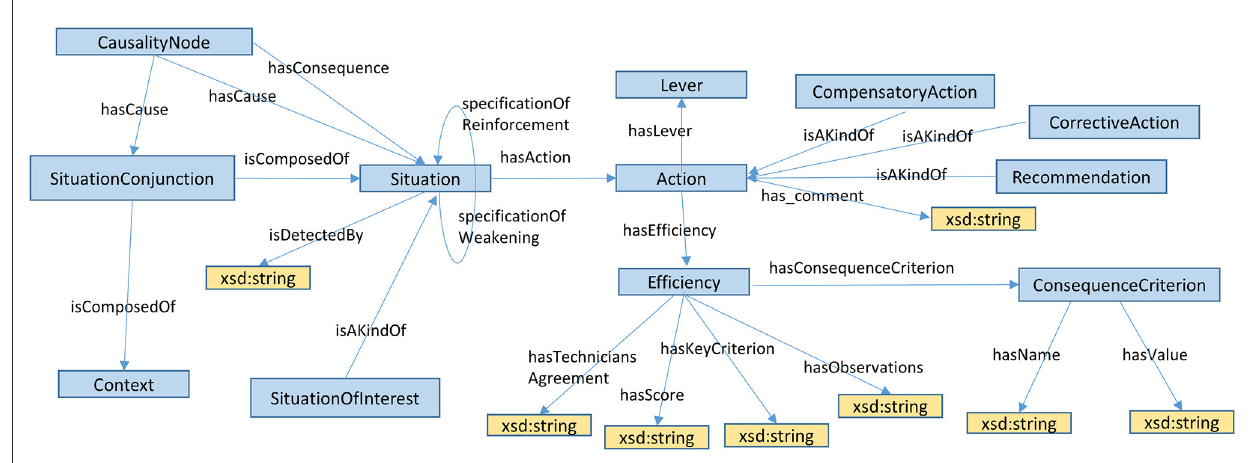
FIGURE2 OWL ontological model used to structure a decision tree in the MCDSS knowledge